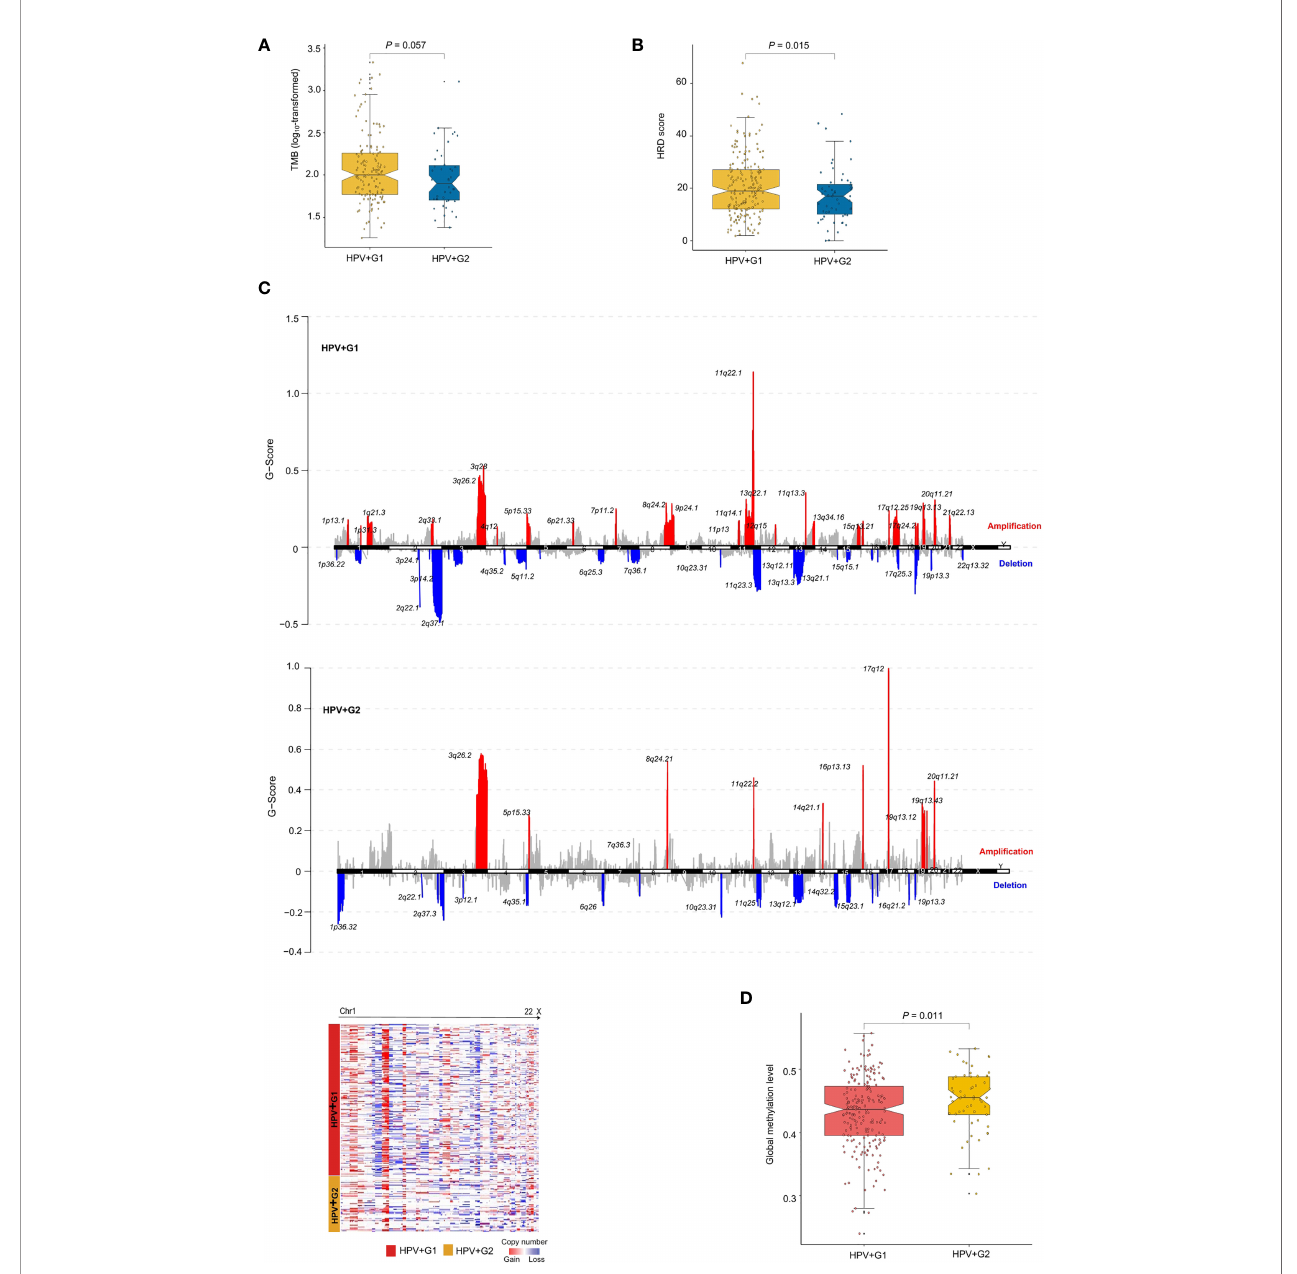
FIGURE 2 | Comparisons of genomic and epigenomic pro fi les between the HPV+ cervical cancer subtypes. HPV+G1 having higher TMB (A) , homologous recombination de fi ciency (HRD) scores (B) , and G-scores of copy number ampli fi cations and deletions (C) , and lower global methylation levels (D) than HPV+G2. The one-tailed Mann – Whitney U test P values are shown in (A, B, D) . The G-score calculated by GISTIC2 (20) represents the amplitude of the copy number alteration and the frequency of its occurrence across a group of